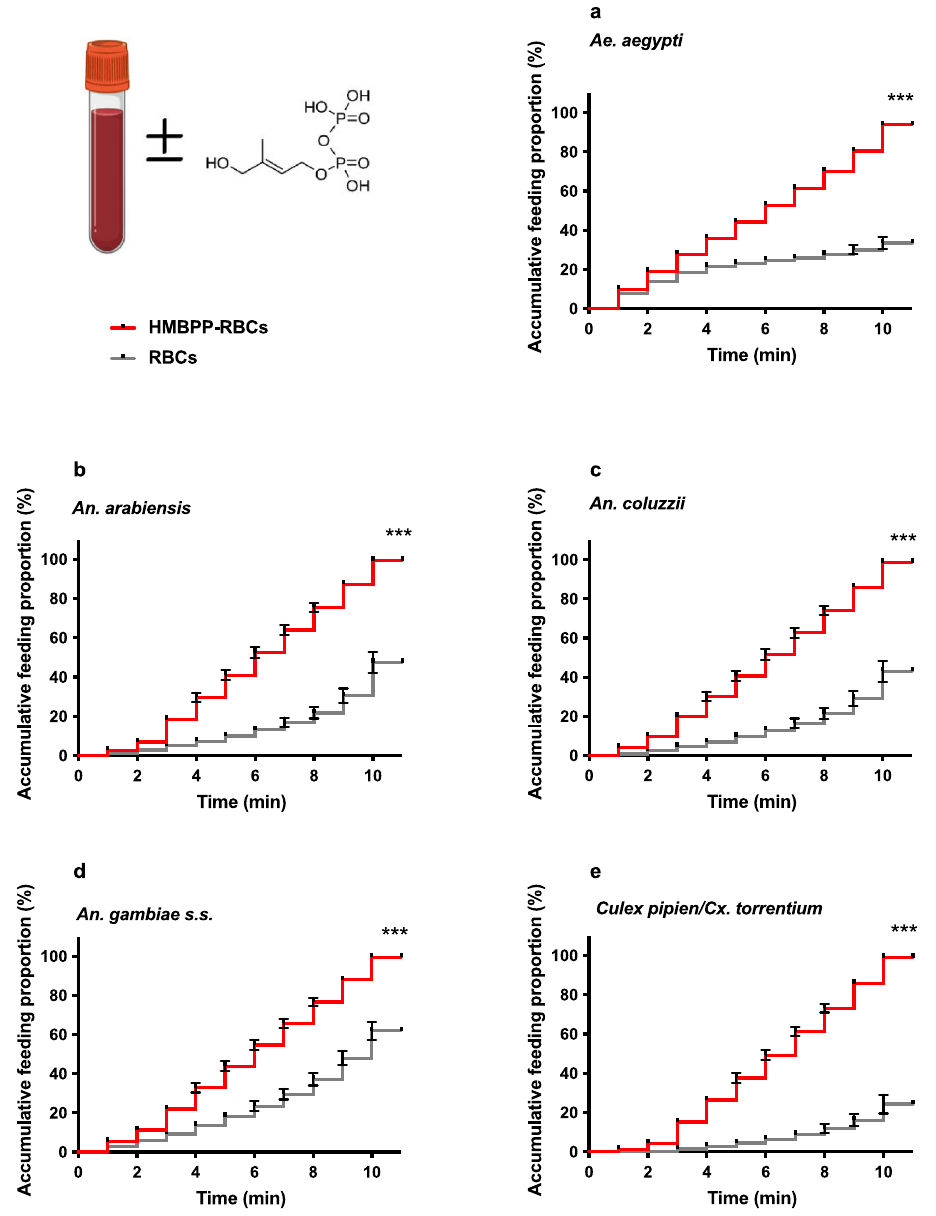
Fig. 1 The direct effect of HMBPP on vectors accumulative feeding proportion. a – e Feeding proportions of mosquito vectors allowed to feed for 10 min on RBCs, or HMBPP-supplemented RBCs (each level of estimation generated from cox proportional hazard model ± SE; RBCs vs HMBPP-RBCs). Percentage of mosquitoes initiating feeding within 10 min on RBCs with and without HMBPP (RBCs vs HMBP-PRBCs) in all fi ve vector species [ Ae. aegypti : χ 2 1 = 183.6, p < 0.001; Culex pipiens/Cx. torrentium : χ 2 1 = 283.7, p < 0.001; An. gambiae s.s .: χ 2 1 = 212.4, p < 0.001; An. arabiensis : χ 2 1 = 210.2, p < 0.001; An. coluzzii: χ 2 = 138.1, p < 0.001]. Error bars, ±SE; asterisks denote signi fi cant differences ( n = 120 per species, * p < 0.05, ** p < 0.01, *** p < 1 arabiensis: z = 3.60, p = 0.001; An. arabiensis vs An. coluzzii: z = 0.16, p = 0.60; An. coluzzii vs Cx. pipiens/Cx. torrentium: z = − 4.89, p < 0.001). However, variation in the time of detection and initiation of the feeder among species vanished when the blood is supplemented with HMBPP ( χ 2 4 = 7.20, p = 0.12). (Fig. 2b). Acidi fi cation of the juice to pH = 4 obliterated the activity (Fig. 2b).